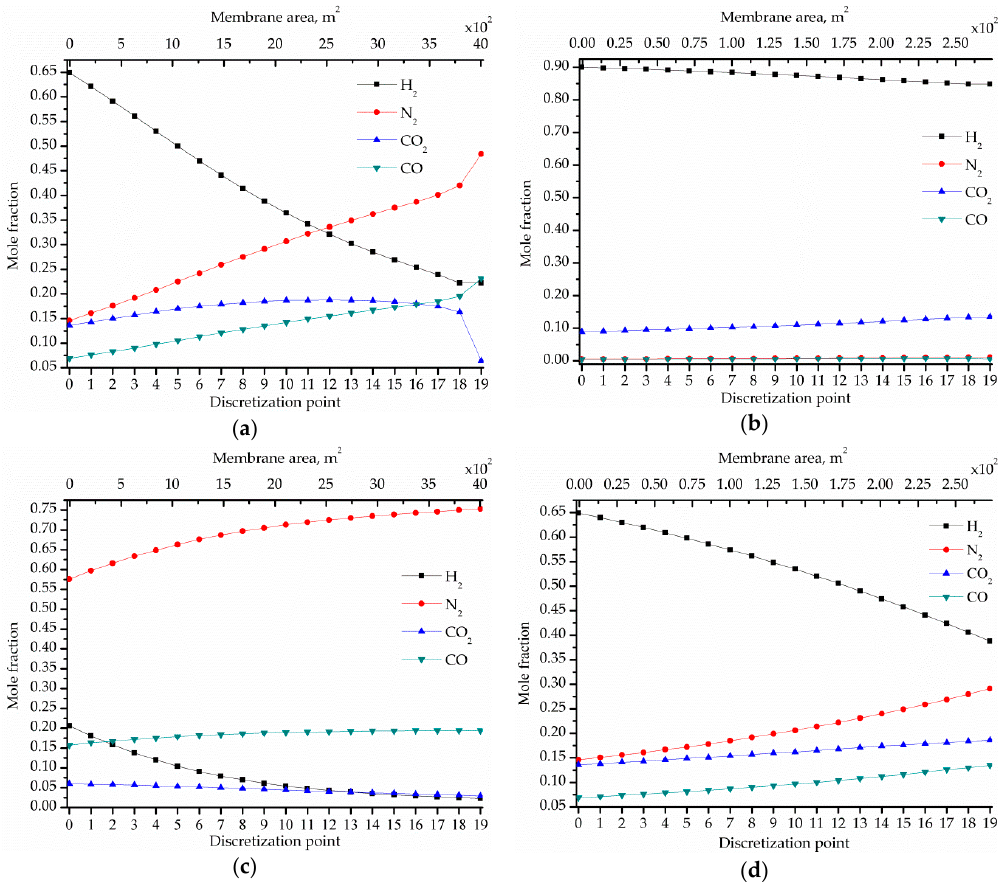
Figure 7. Optimal mole fraction profiles of the components in the membrane modules obtained in solution SUBOPT1, in which the driving force for permeation is created by compression of the feed and permeate streams only (no vacuum) and no expander is included: ( a ) permeate in MS1; ( b ) permeate in MS2; ( c ) retentate in MS1; ( d ) retentate in MS2.